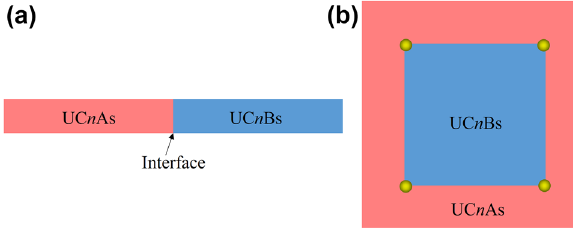
Figure 3: Sketchs of the supercell and the metastructure for the calculationof (a)Topologicaledgestatesand(b) Topological corner states.